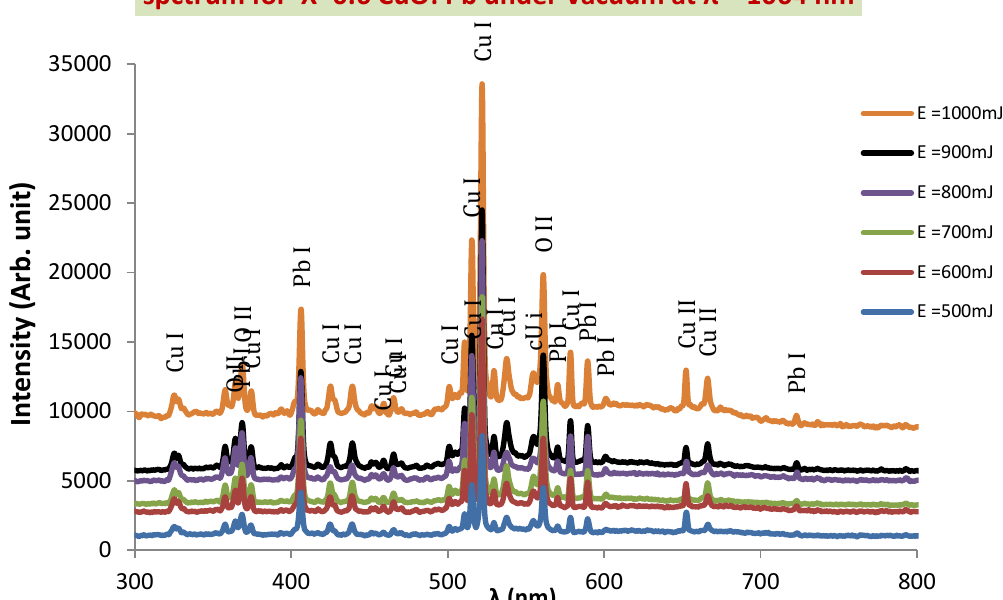
Fig. 2: Emission spectra of laser induced on CuO:Pb component at X=0.6 target in vacuum with different laser